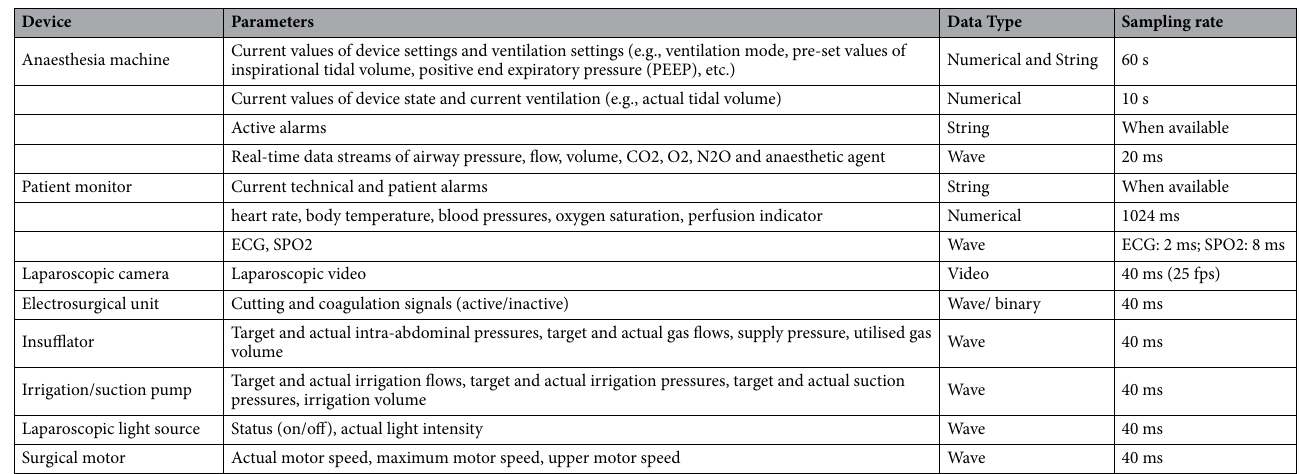
Table 4. Devices and their data streams acquired during the